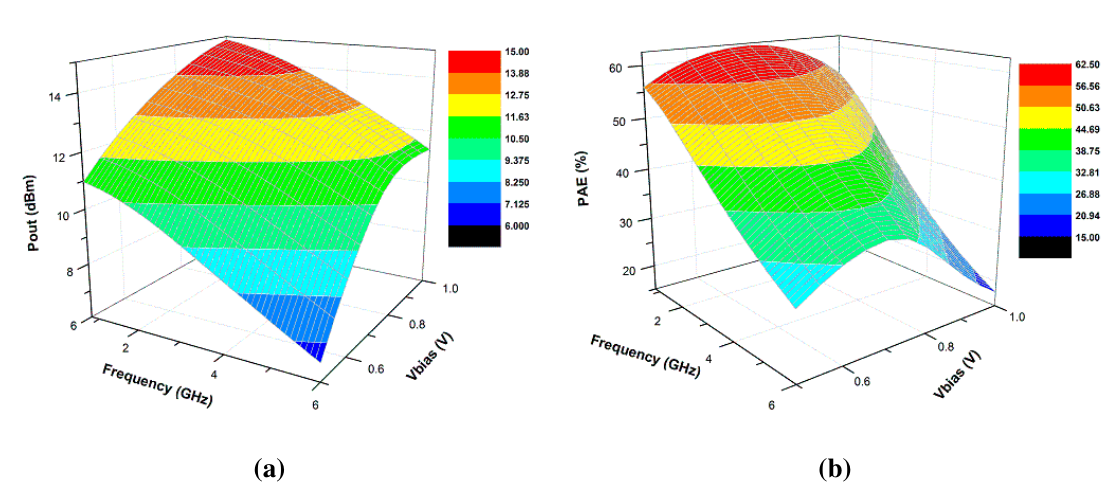
Figure 6. ( a ) Gate biasing and frequency versus output power; ( b ) gate biasing and frequency versus power-added